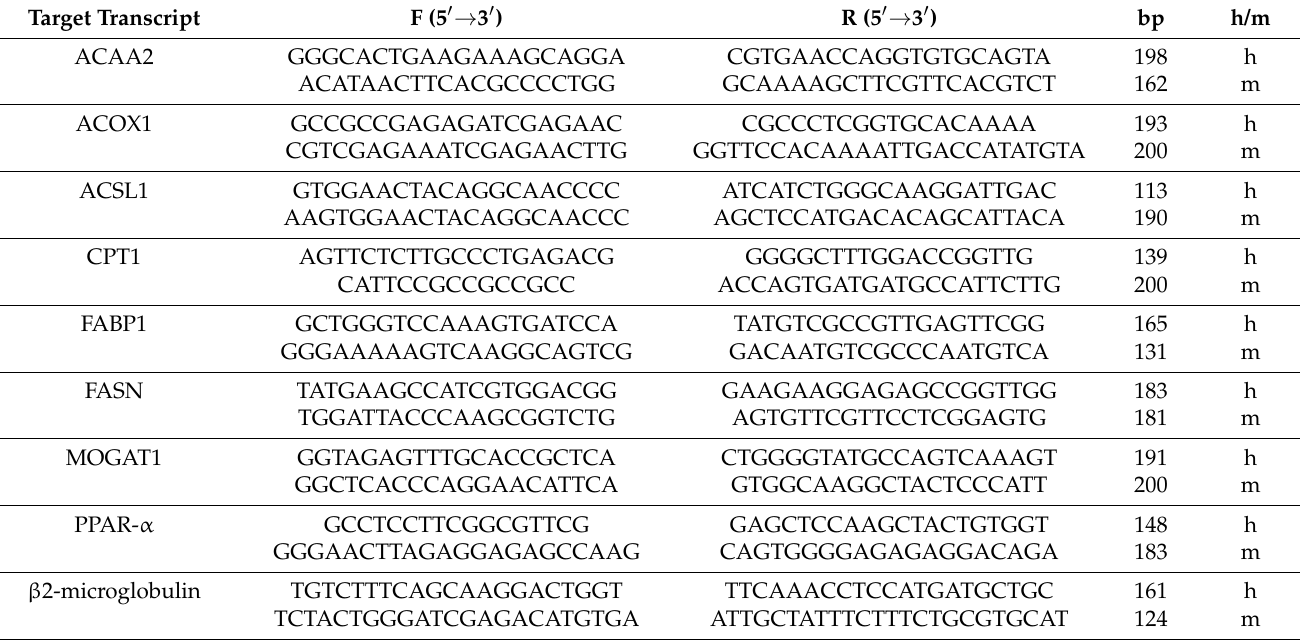
Table 2. List of human (h) and mouse (m) primer pairs used for